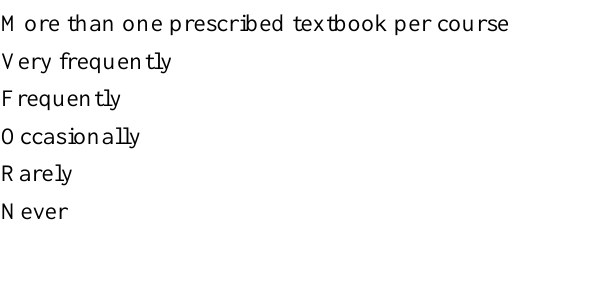
Frequency of More than One Prescribed Textbook per Course